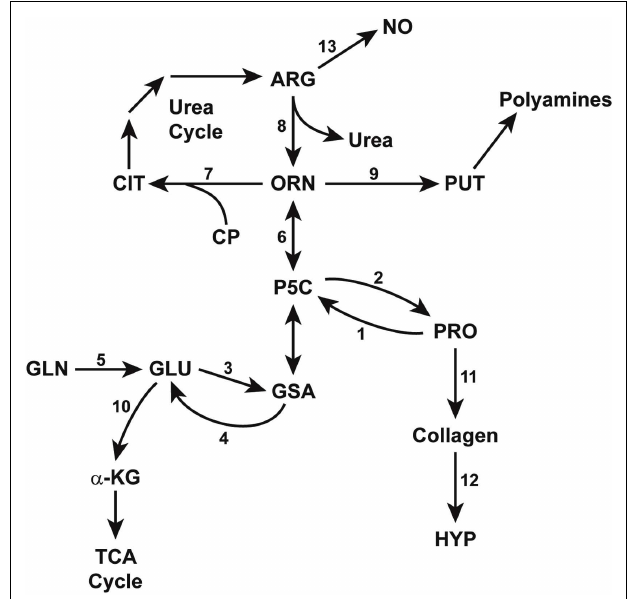
FIGURE 3 | Enzymatic pathways in the interconversions of glutamine, arginine, and proline. GSA (glutamic- γ -semialdehyde) and its tautomer, P5C ( ∆ 1 -pyrroline-5-carboxylate) bridge the pathways from glutamine to arginine, thereby linking theTCA and urea cycles. Some reactions are mediated by multiple isozymes with distinct subcellular localizations and functions.The abbreviations are: PRO, proline; HYP, hydroxyproline; GLU, glutamate; GLN, glutamine; a-KG, alphaketoglutarate; ORN, ornithine, CIT, citrulline, ARG, arginine; NO, nitric oxide; PUT, putrescine; CP, carbamyl phosphate. Enzymes catalyzing these reactions are designated by numbers: 1, proline oxidase/dehydrogenase; 2, P5C reductase; 3, P5C synthase; 4, P5C dehydrogenase; 5, glutaminase; 6, ornithine aminotransferases; 7, ornithine transcarbamylase; 8, arginase; 9, ornithine decarboxylase; 10, glutamate dehydrogenase; 11, protein synthesis; 12, prolyl hydroxylase; 13, nitric oxide